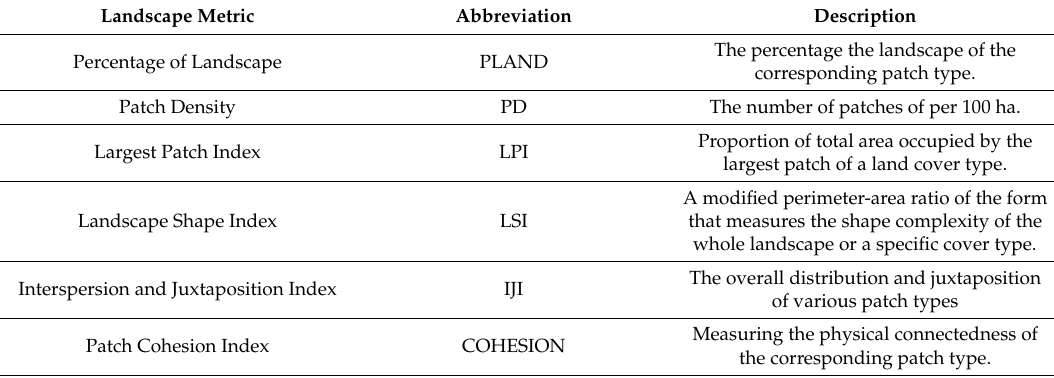
Table 1. The formulas for the landscape metrics are listed in Equations (A1)–(A6). Table 1. Landscape metrics used in this